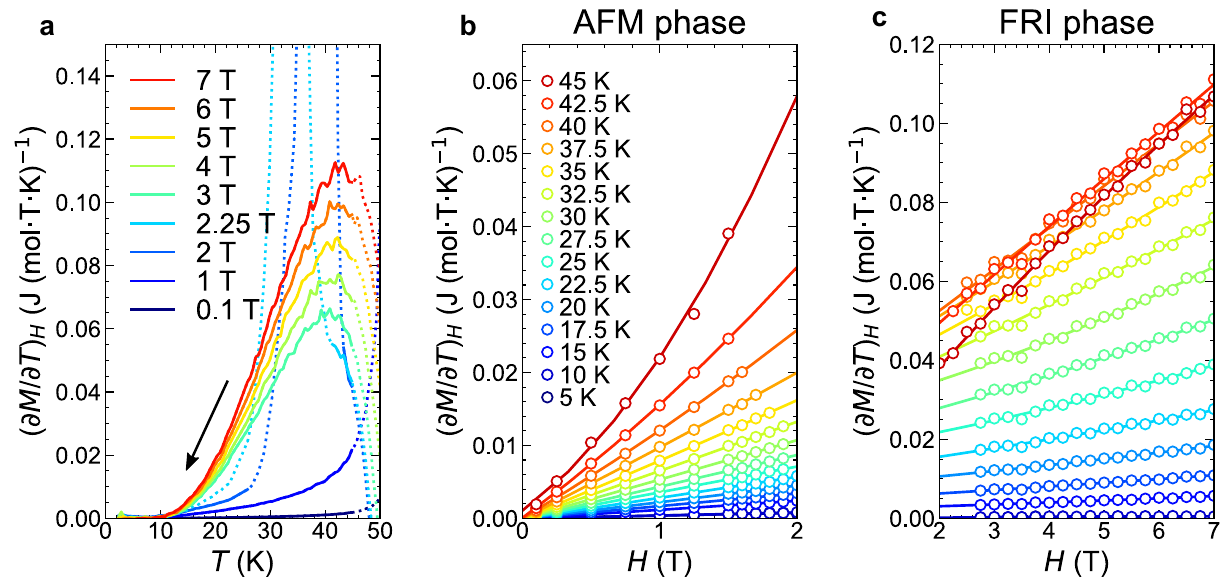
∂ S Figure 4. Derivation of isothermal curves via the Maxwell relation. ( a ) dM dT − T curves measured upon ∂ H T decreasing temperature. The data indicated by the dotted lines were not used for the Maxwell relation. ( b,c ) (cid:30) (cid:31) Isothermal dM dT − H curves of the ( b ) AFM and ( c ) FRI phases. The solid lines represent the best-fit results (see the main text). The legend shown in ( b ) also applies to ( c